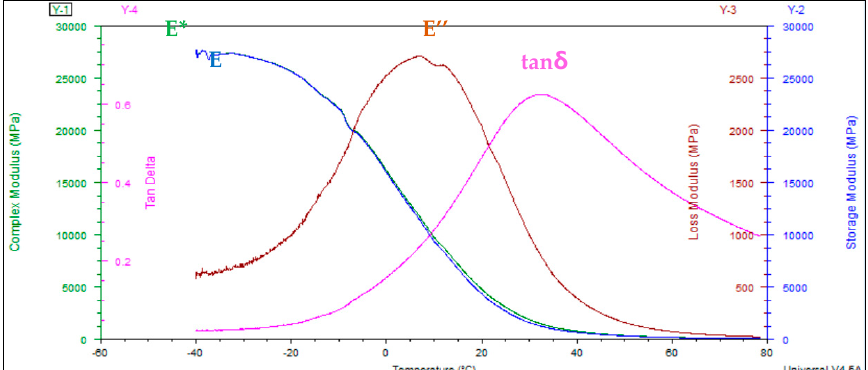
Figure 6. Parameters from temperature sweep test.